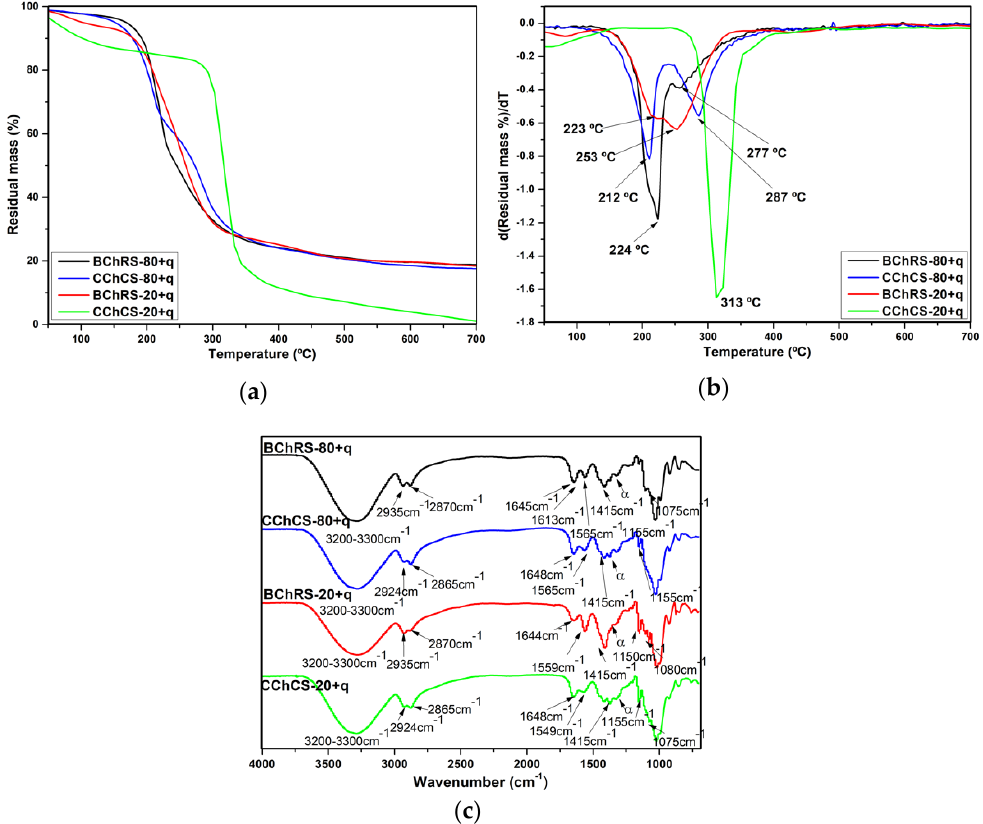
Figure 4. TGA ( a ) and DTGA ( b ) curves and ( c ) FTIR spectra for BChRS-80+q, CChCS-80+q, BChRS- 20+q, and CChCS-20+q (The peak α corresponds to 1320 cm − 1 ).